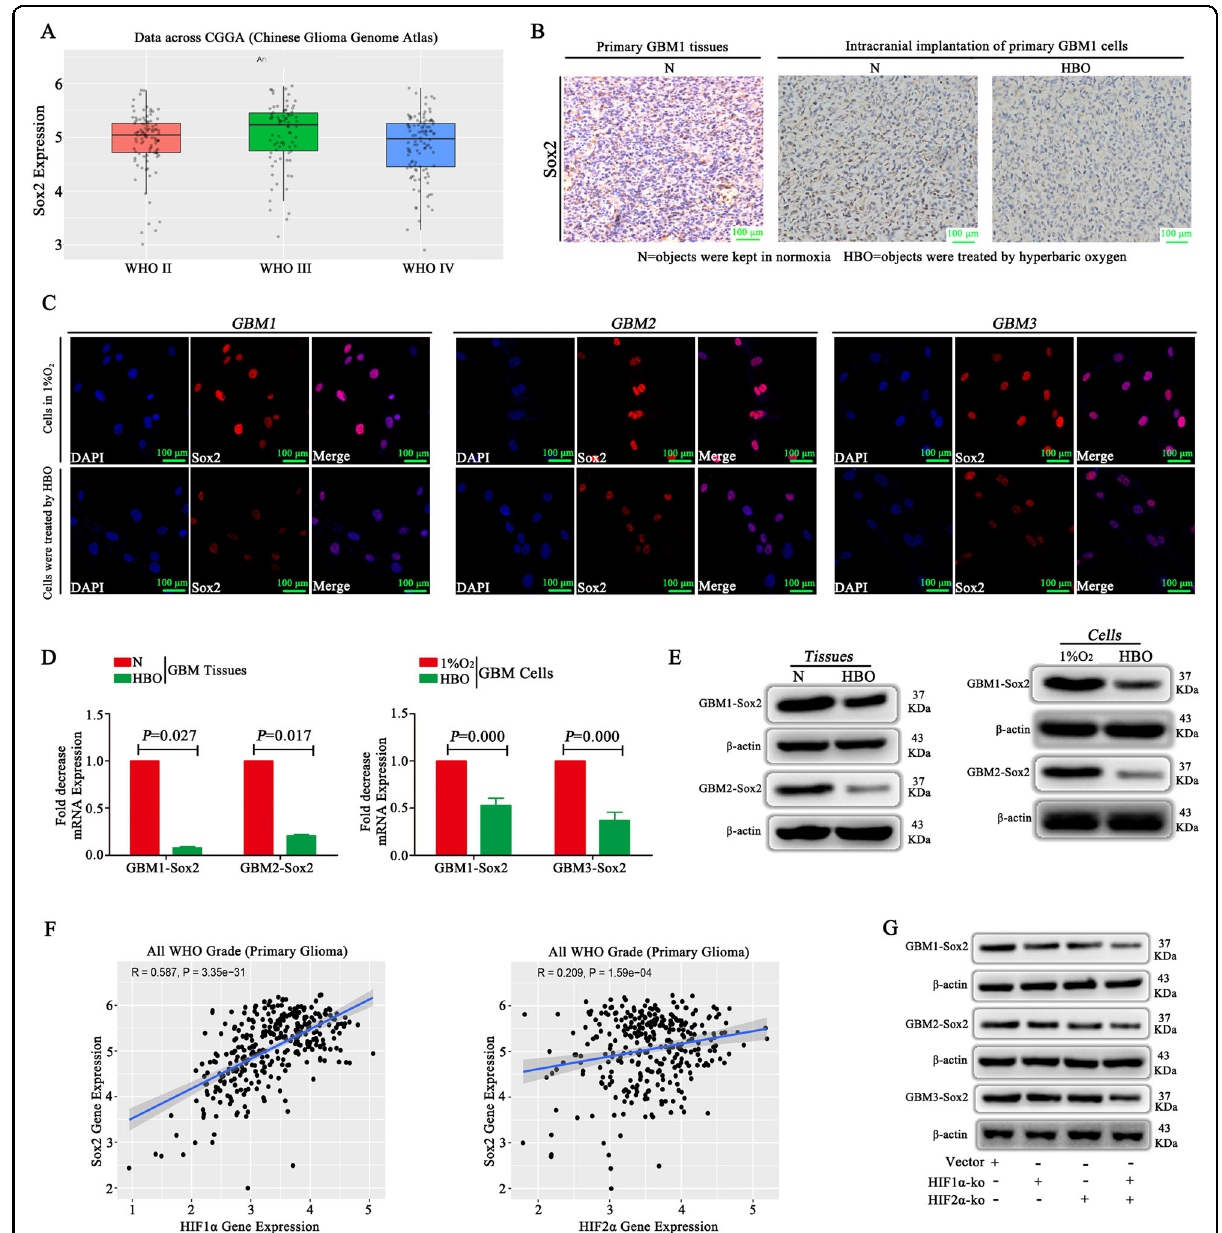
Fig. 4 HIF1 α and HIF2 α regulate Sox2 expression. A An analysis of the CGGA database showed that Sox2 was highly expressed in GBM tissues. B IHC demonstrated that Sox2 was highly expressed in primary GBM and intracranial transplantation tumour tissues. However, after HBO treatment, Sox2 expression decreased signi fi cantly. C Sox2 was highly expressed in cells cultured in 1% O 2 , but after exposure to HBO, Sox2 levels decreased signi fi cantly. D , E RT-qPCR and western blot revealed that Sox2 expression was high in cells cultured in 1% O 2 but decreased signi fi cantly after HBO treatment and both HIF1 α and HIF2 α were decreased in tumour tissues after HBO treatment. F Both HIF1 α and HIF2 α had a positive correlation with Sox2 according to analysis of the CGGA database. G Sox2 expression decreased after HIF1 α or HIF2 α knockout; however, the lowest expression was observed in the cells in which both HIF1 α and HIF2 α were knocked out. The P value was determined by an independent samples t-